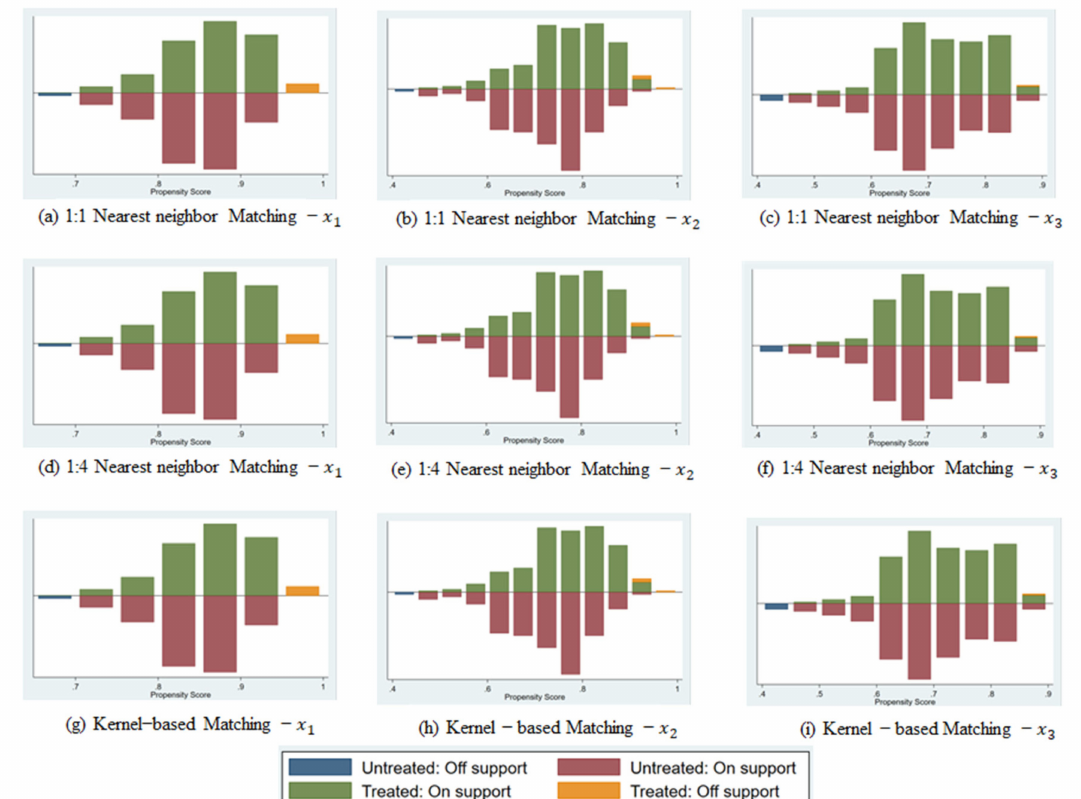
Figure 2. Influence of the cohort effect after bias